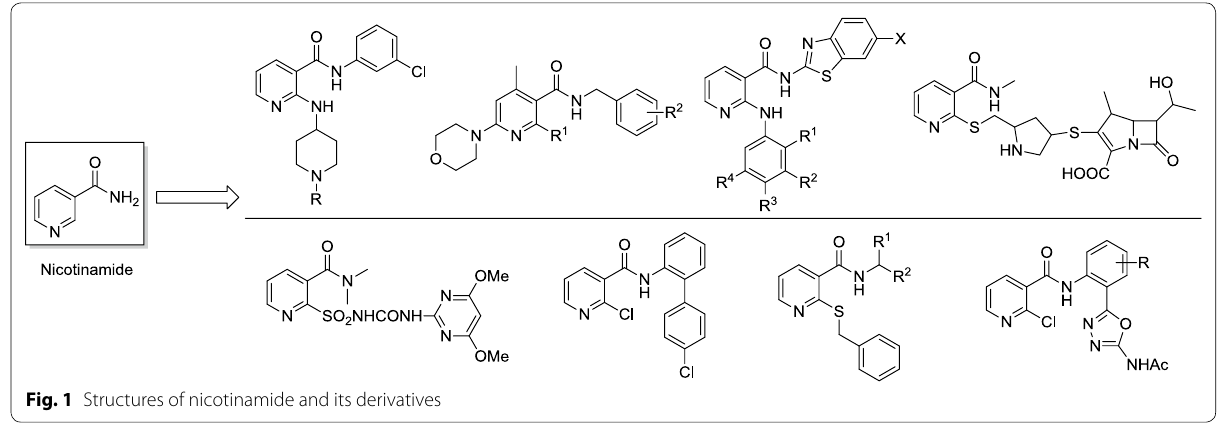
Fig. 1 Structures of nicotinamide and its derivatives